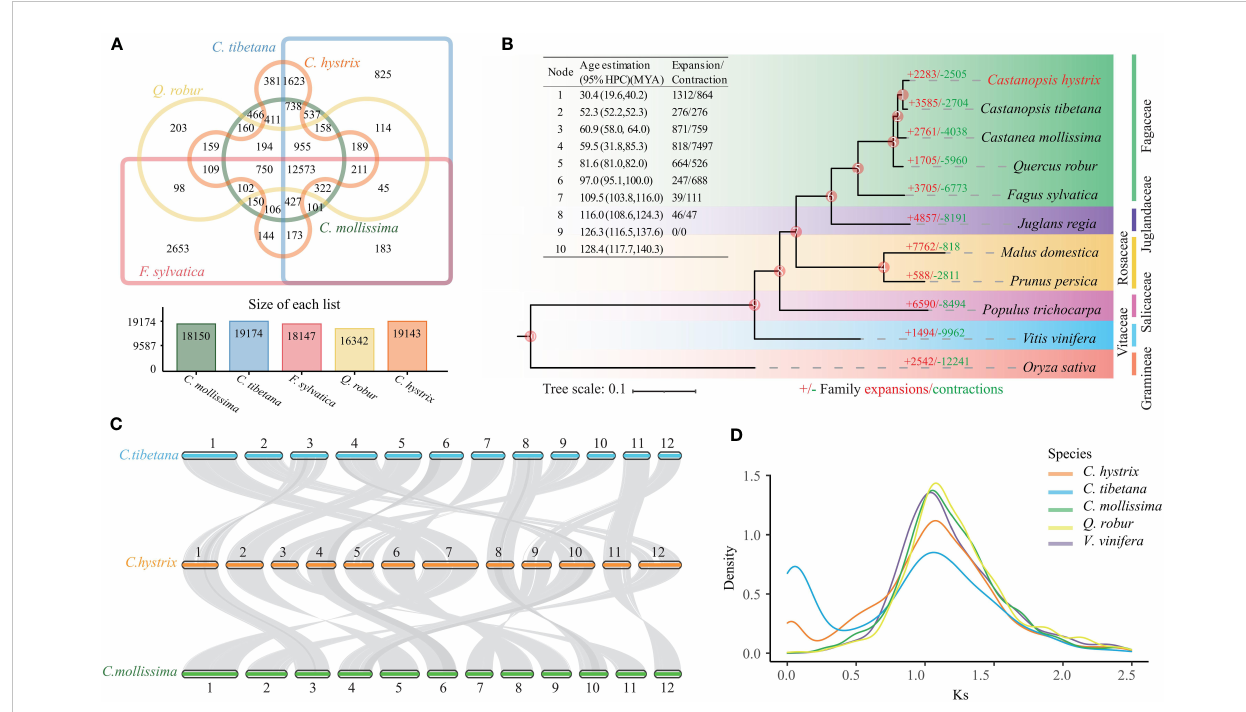
FIGURE 2 Genomic evolutionary and comparative genomic analyses. (A) Shared and unique gene families in C hystrix , C tibetana , C mollissima , Q. robur , and F sylvatica . (B) Phylogenomic tree and expansion and contraction of gene families among C hystrix and 10 other species. Numbers in red (+) and green ( − ) show the number of expanded and contracted gene families, respectively. (C) The synteny blocks between C hystrix , C tibetana , and C mollissima. Syntenic blocks were connected by grey lines. (D) The synonymous substitution rates (Ks) distributions of paralogous